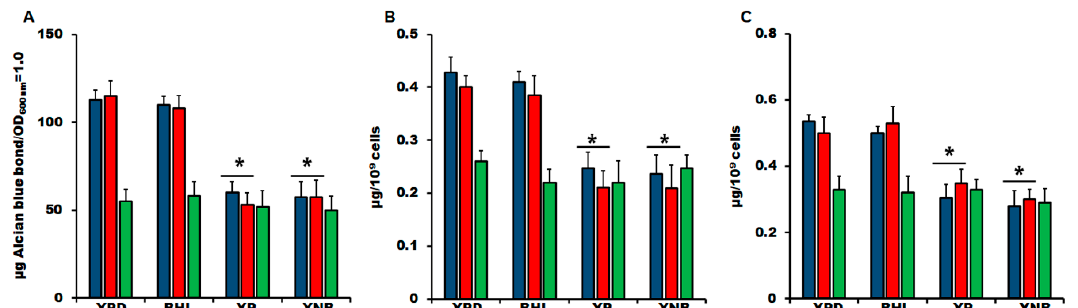
Figure 4. Cell wall binding ability and glycan content of Sporothrix spp. yeast-like cells grown in di ff erent culture media. Yeast-like cells from Sporothrix schenckii (blue bars), Sporothrix brasiliensis (red bars), or Sporothrix globosa (green bars) were grown in the indicated culture medium and used to calculate the cell ability to bind the cationic dye Alcian blue ( A ) or were treated with either endoglycosidase H ( B ) or β -elimination ( C ) to remove N -linked and O -linked glycans, respectively. Results are the media ± standard deviation from three independent experiments performed by duplicate. * p < 0.05 when compared to the sugar content of YPD- or BHI-grown cells.